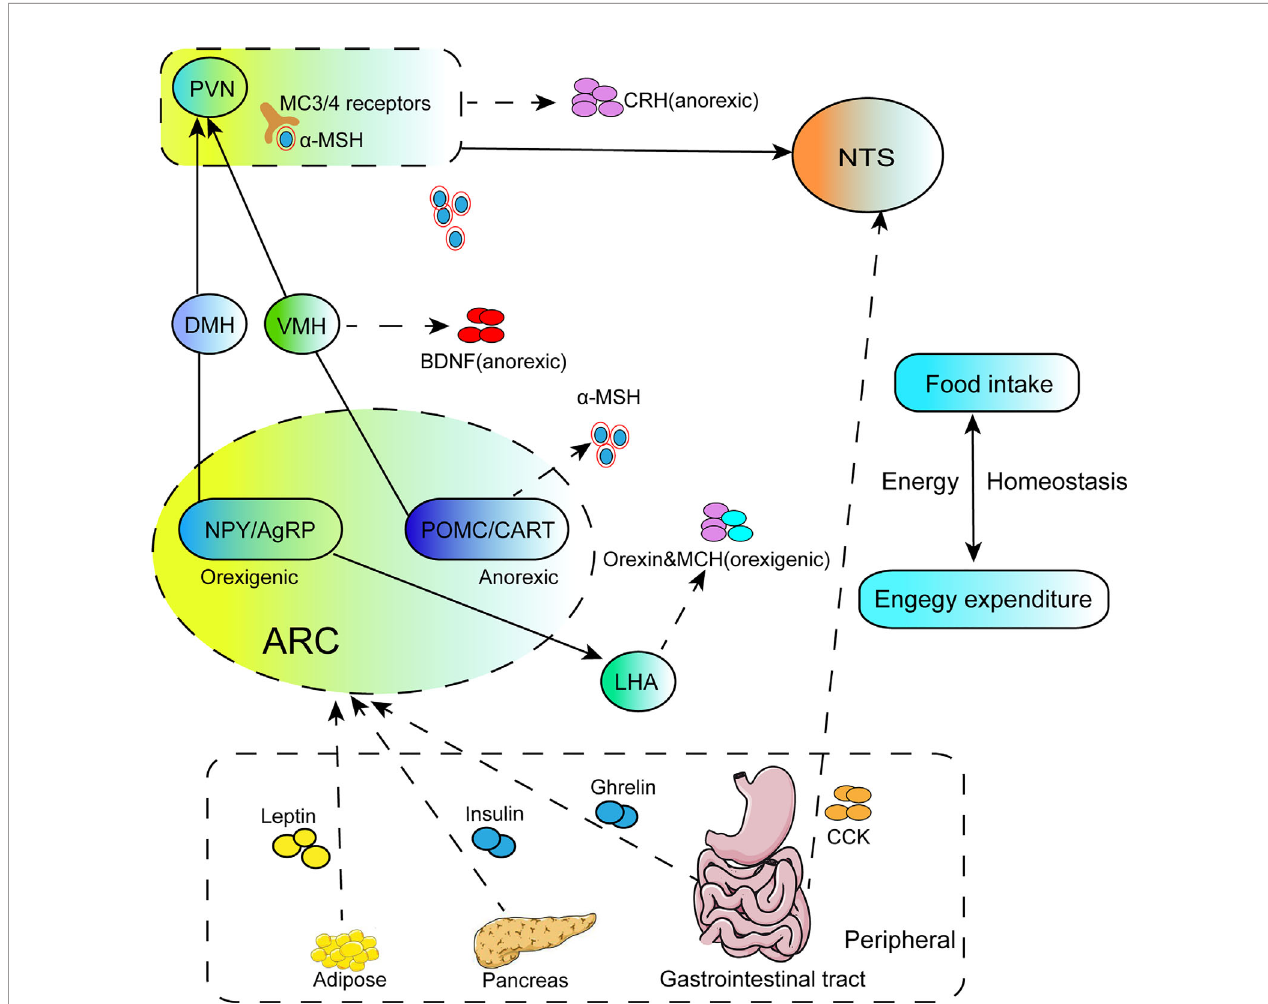
FIGURE 1 | The illustration focuses on the regulation of energy homeostasis by the hypothalamus. NPY/AgRP and POMC/CART neurons located in the ARC of hypothalamus project to secondary neurons such as PVN, DMH, VMH, LHA, and secrete orexigenic AgRP or anorectic POMC. The MC3/4R in PVN are activated after binding with the active component a-MSH cleaved by POMC, and the integrated signals are transmitted to the NTS to regulate feeding behavior. Meanwhile, PVN also secretes anorexic neurohormones CRH to suppress food intake. BDNF located in the VMH is the downstream effector of a-MSH, which plays a role in inhibiting food intake. LHA is mainly stimulated by NPY/AgRP neurons in the ARC and secretes orexigenic peptides, orexin and MCH. Peripheral signals from adipose tissue, pancreas or the gastrointestinal tract either enter the hypothalamus through the median eminence, or connect to the NTS in the brainstem via acting on the vagus nerve afferents, and these signals effectively induce activities of the related nuclei, such as ARC and NTS, then in fl uence the second order neurons of PVN, VMH. DMH and